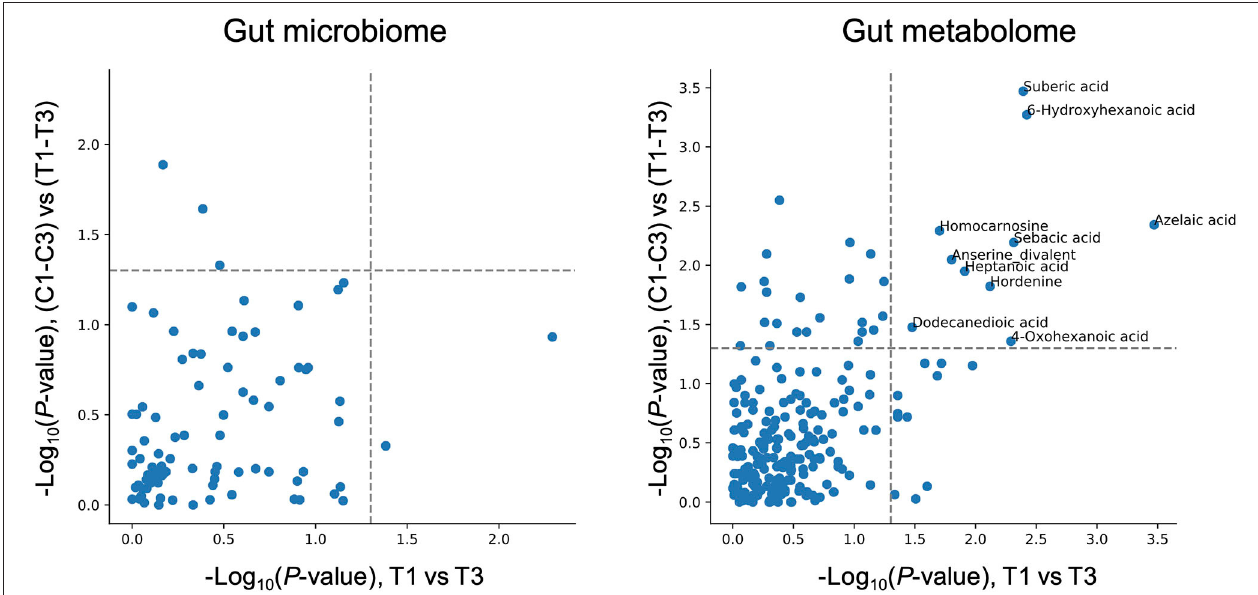
FIGURE 3 | Chlorella intake significantly alters some intestinal metabolite levels. The X -axis indicates the logarithmic P -value of the Wilcoxon signed-rank test for each bacterial taxon/metabolite between T1 and T3. The Y -axis indicates the logarithmic P -value of the Wilcoxon signed-rank test for each bacterial taxon/metabolite between T1–T3 and C1–C3 (T1–T3 means differences between T1 and T3 within each subject treated as one group). Bacterial taxon/metabolite names are labelled if a significant difference was detected in both statistical